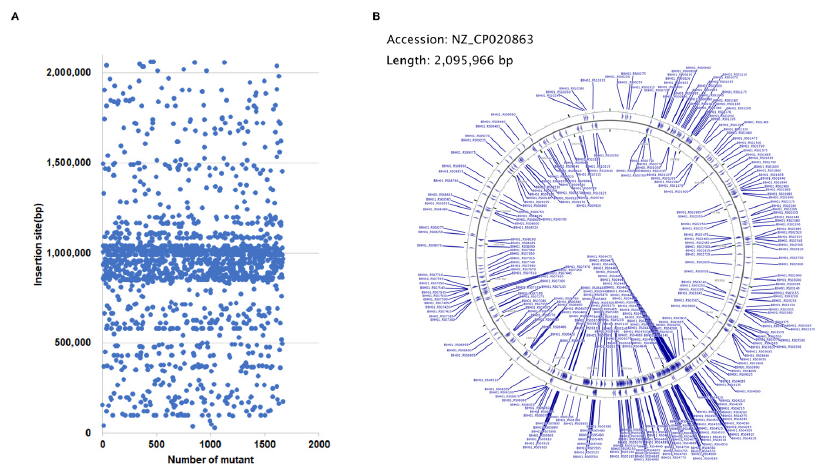
Figure 1. Location of transposon insertion sites in the genome of S. suis SC19. ( A ) Scatter plot of the positions of the Tn insertion sites. Blue spots represent the position (bp) of the 1665 mutants in the SC19 genome where the transposition inserted sites are located. ( B ) Mapping of the Tn insertion sites to the genome of S. suis SC19 strain. CGView Server was used to visualize the distribution of the inserted genes involved in the mutant library on the S. suis SC19 genome.